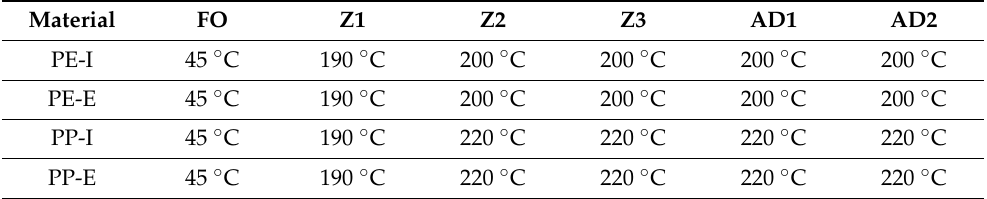
Table 2. Temperature program in °C for the heating zones of the single-screw extruder.